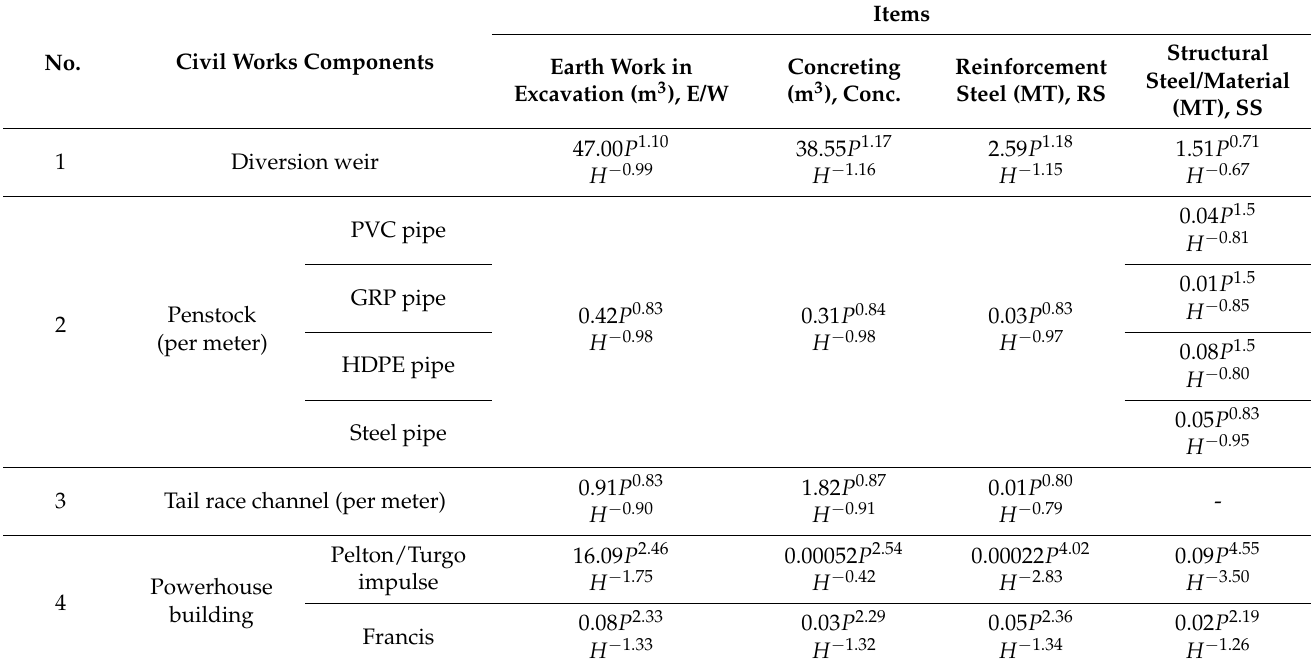
Table 7. Correlations of civil works for run-of-river small hydropower plant scheme